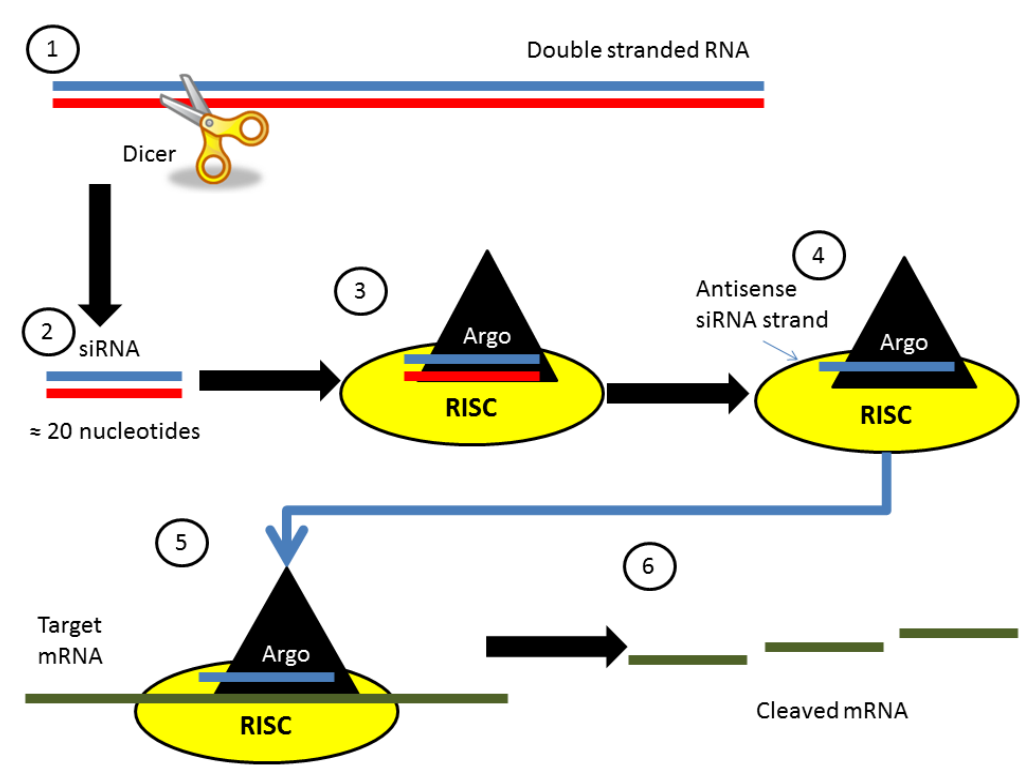
Figure 1. Molecular pathway for siRNA